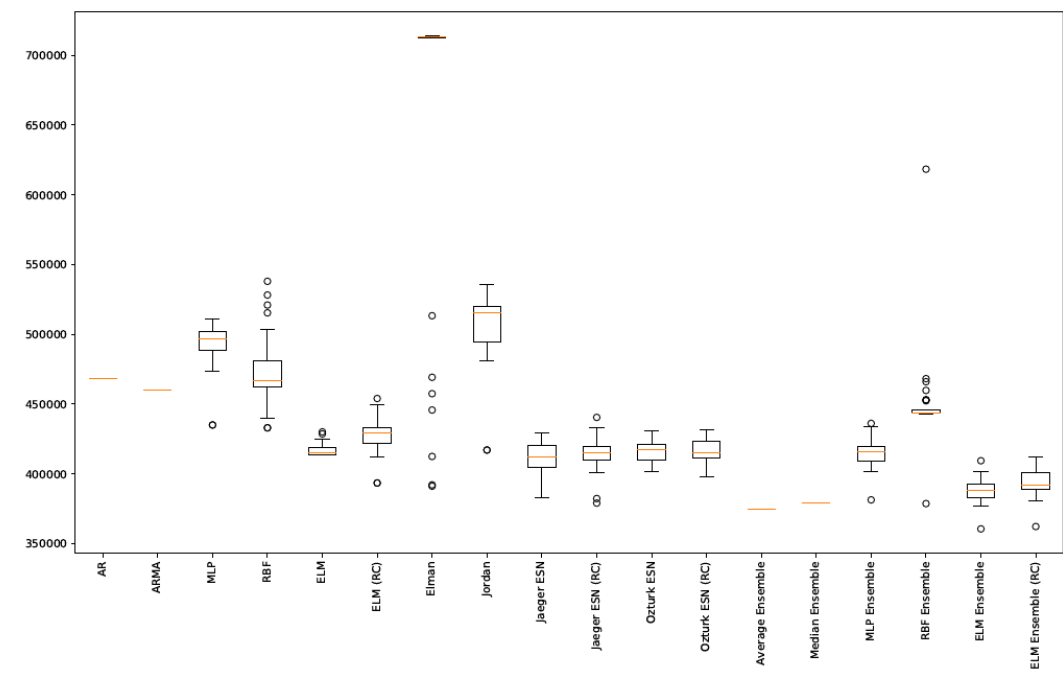
Figure 6. Boxsplot Á gua Vermelha, 2006 at 2015–30 executions.